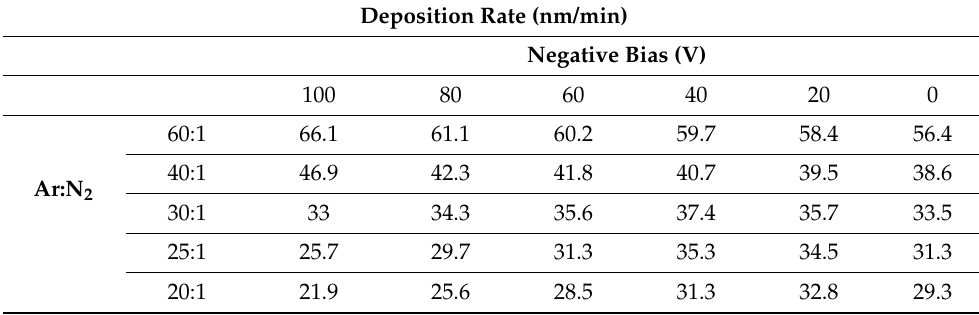
Table 11. Effect of process parameters on film deposition rate of TiN